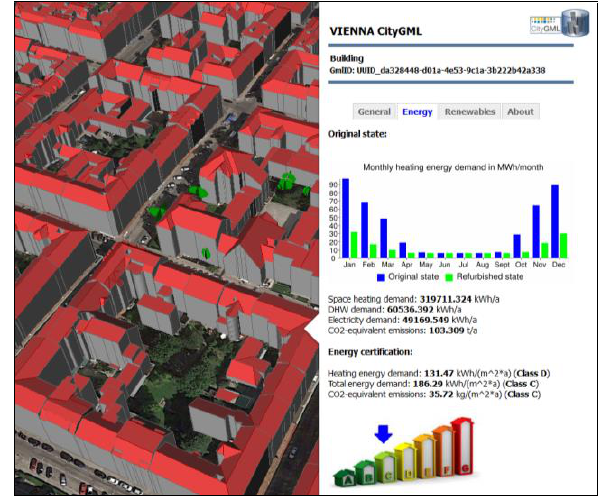
Figure 4. The Google Earth balloon contains information